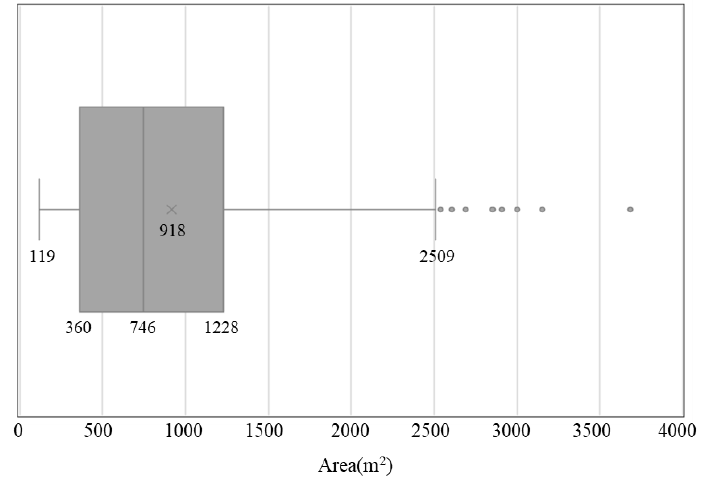
Figure 2. Boxplot of floor area of multi-functional activity centers.